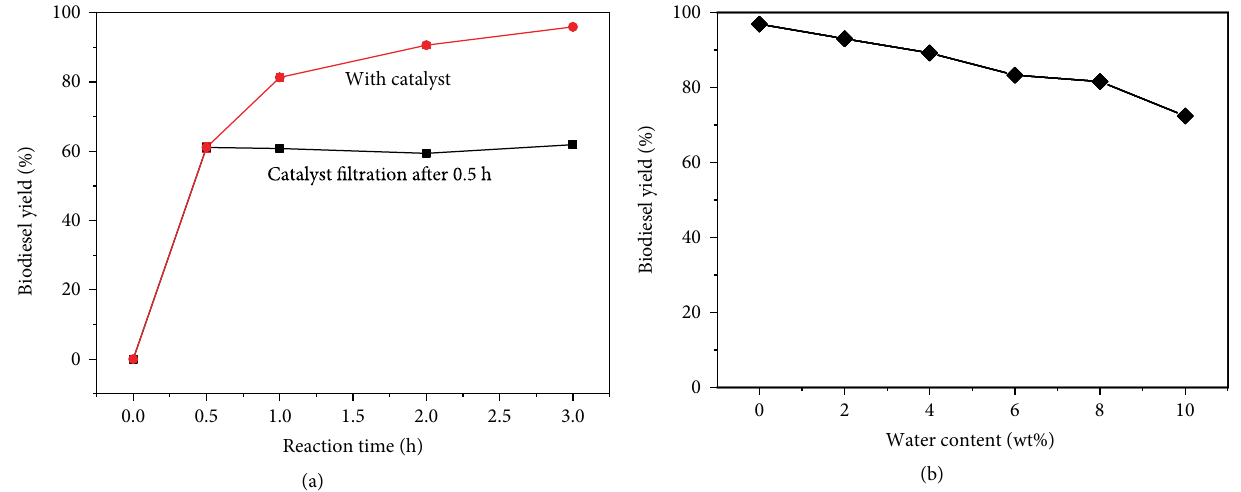
Figure 5: (a) Hot filtration test of CS-SO conditions: temperature 75°C, the CS-SO